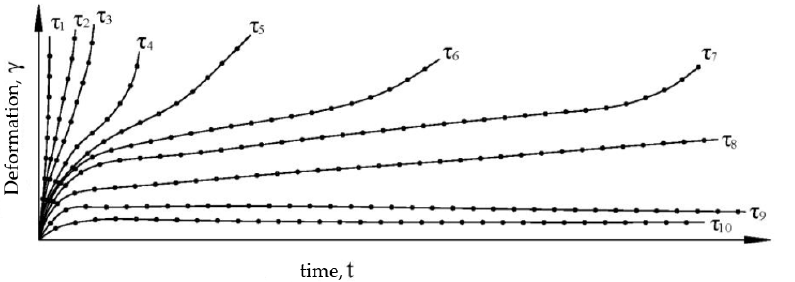
Figure 2. Curves describing the shear creep of clay according to S.S. Vyalov, 1978. [2] ( τ s is the limiting value of tangential stresses (shear stresses)).